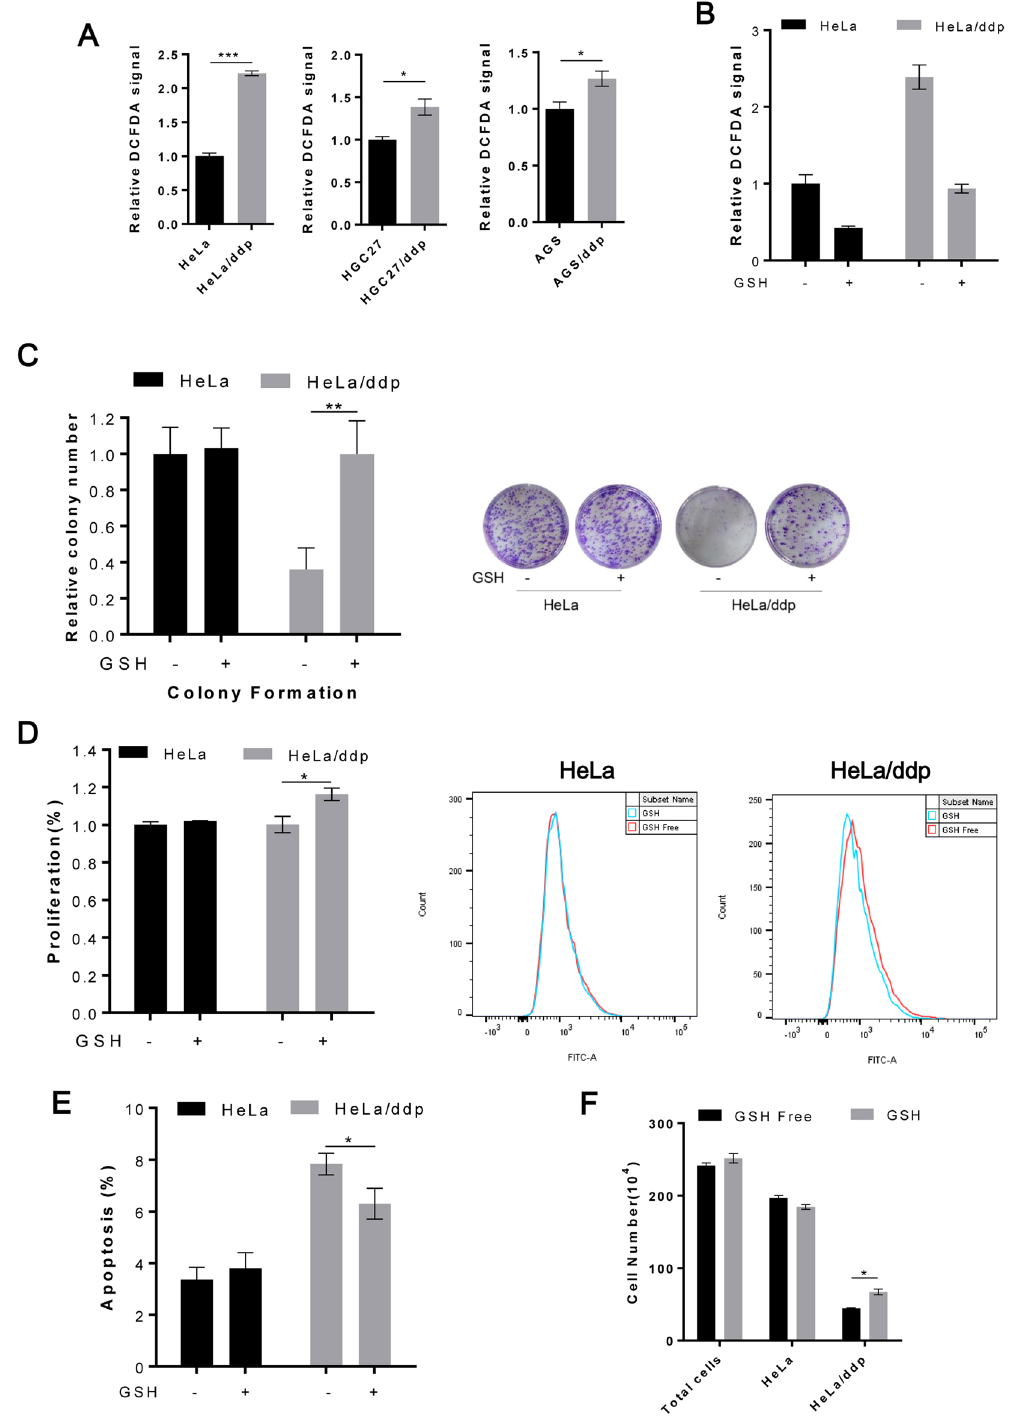
Figure 3. The growth disadvantage of ddp-resistant cells is rescued by decreasing ROS levels. ( A ) Relative ROS levels in HeLa, HeLa/ddp, HGC27, HGC27/ddp, AGS and AGS/ddp cells. ( B ) Relative ROS levels in HeLa and HeLa/ddp cells under the indicated conditions. ( C ) Relative clonogenic growth of HeLa and HeLa/ddp cells under the indicated conditions. GSH (4 mM) was added to the medium on the following day. ( D ) Relative proliferation of HeLa and HeLa/ddp cells under the indicated conditions. Proliferation was determined through CFSE assays after six days. ( E ) Relative apoptosis of HeLa and HeLa/ddp cells under the indicated conditions. ( F ) Growth of HeLa and HeLa/ddp cells when cultured together; HeLa cells were labeled with CFSE; HeLa cells and HeLa/ddp cells were plated in 6-well plates at 2 × 10 5 cells per well in an equal ratio; GSH (4 mM) was added to the medium on the following day. Total cell numbers were counted with a Hand-held Automated Cell Counter, and the ratio of sensitive cells was analyzed via flow cytometry. The error bars represent the s.d. of triplicate wells of a representative